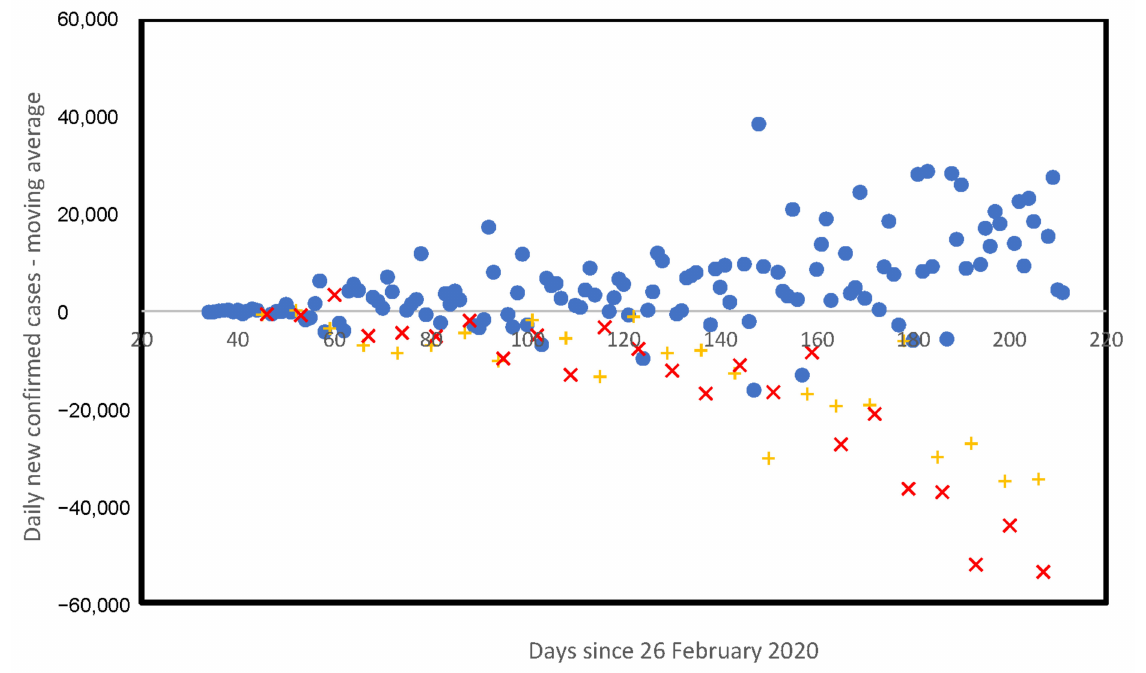
Figure 9. Smoothed confirmed world daily new cases [30], from Figure 7, as a function of days since 26 February 2020 until 23 August 2020 + indicates Sundays, X indicates Mondays. For each specific day j, the mean number of confirmed daily new cases calculated for days j − 1, j − 2, j, j + 1 and j + 2 is subtracted from the number for day j.